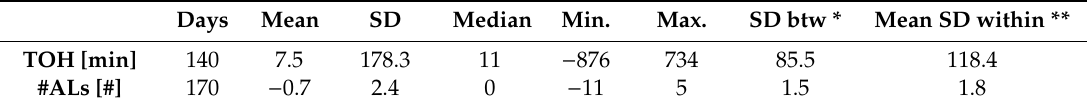
Table 4. Summary statistics for daily difference between self-reported and sensor-derived mobility indicators.